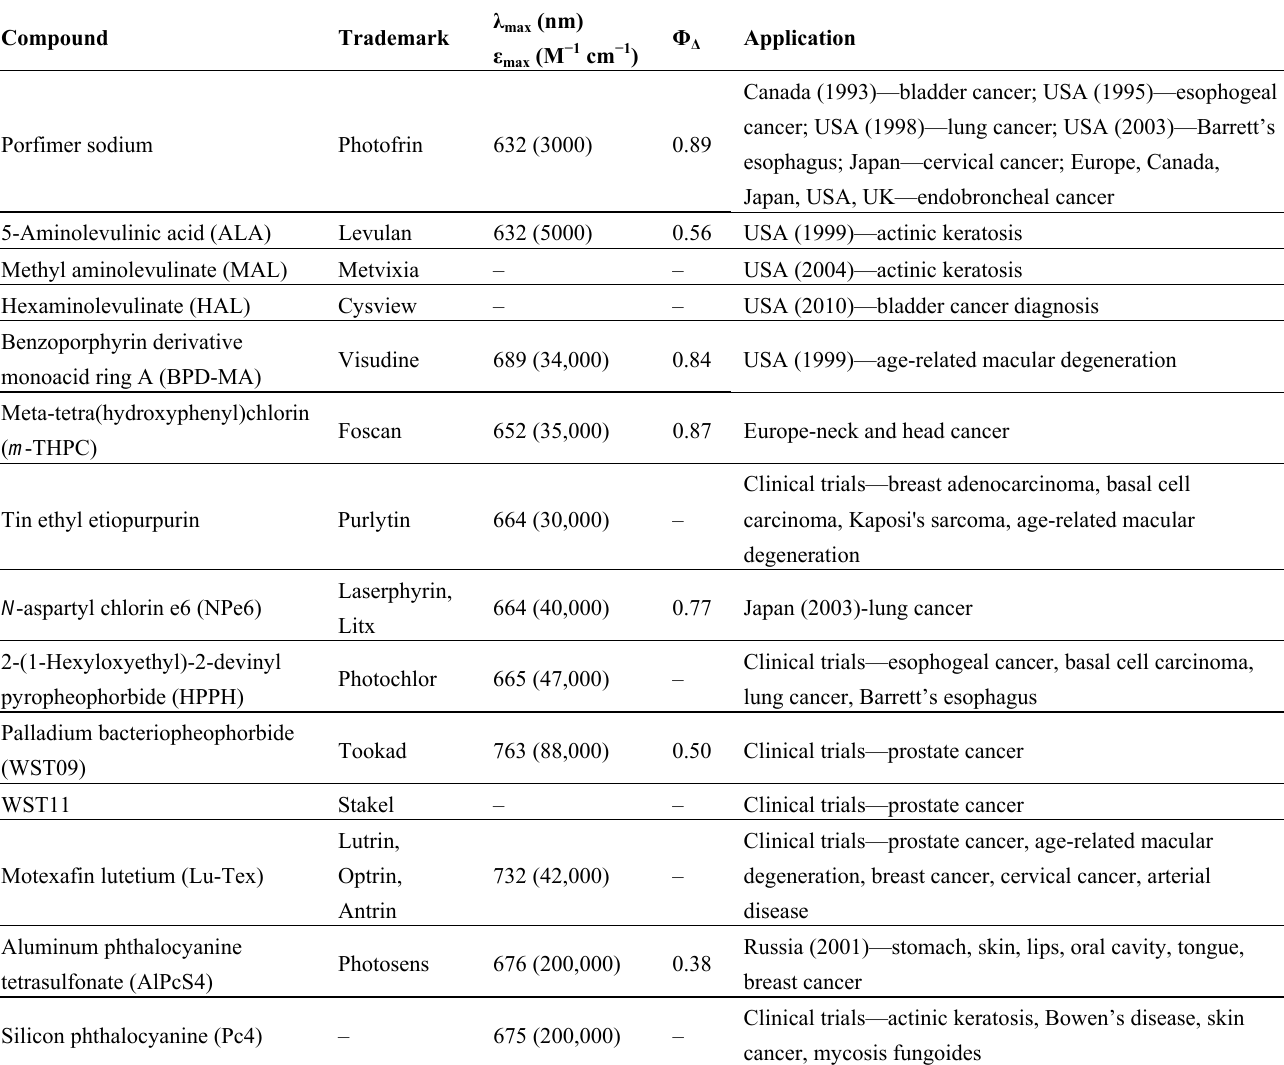
Table 2. Properties of some photosensitizer dyes approved for PDT treatment and used in PDT-related clinical